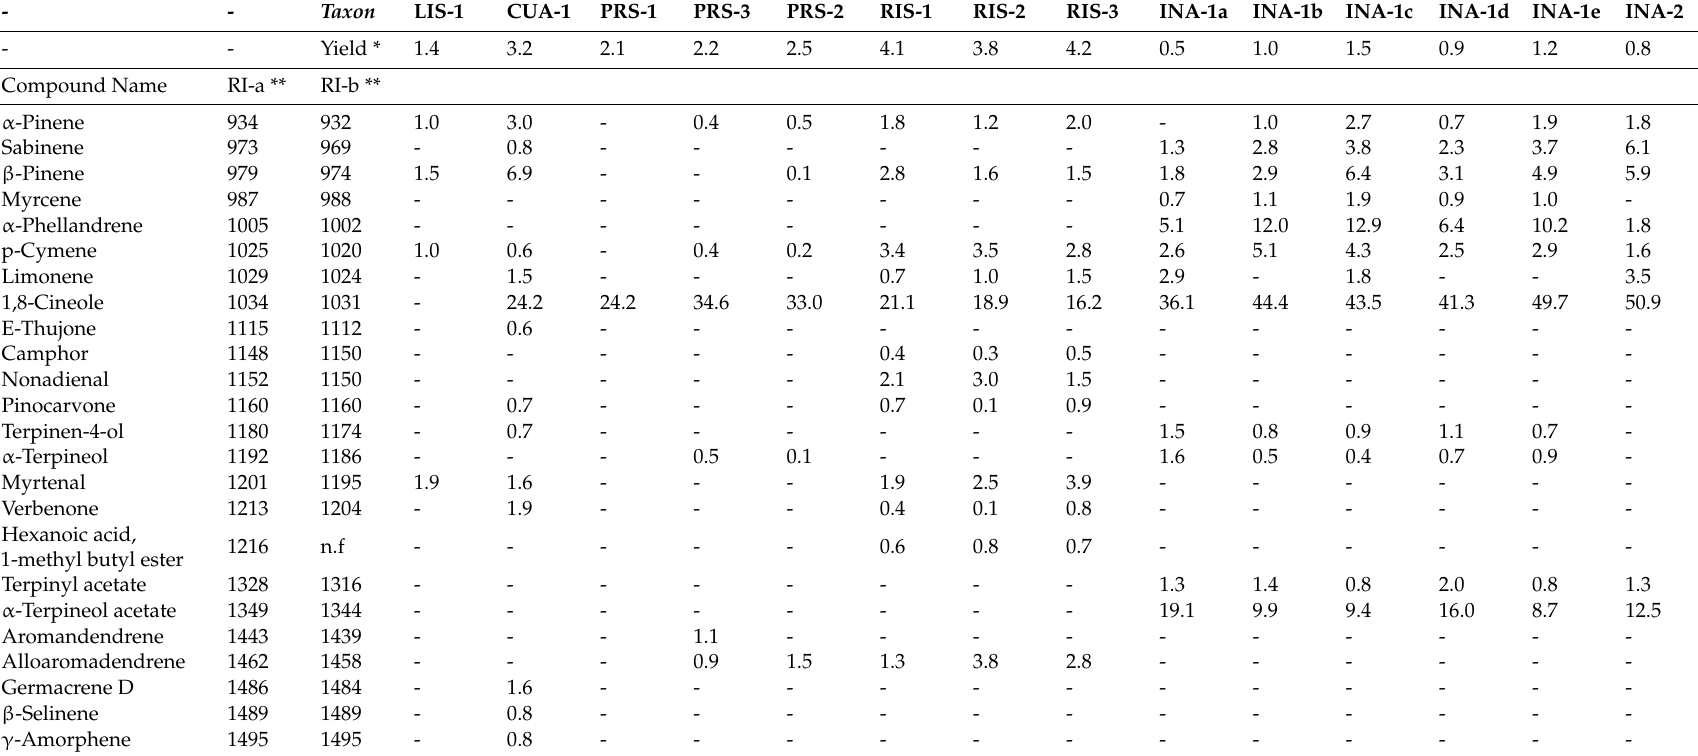
Table 3. Chemical character of essential oils from miscellaneous species of Prostanthera . LIS = P. lithospermoides , CUA = P. cuneata , PRS = P. prunelloides , RIS = P. ringens, INA = P. incisa